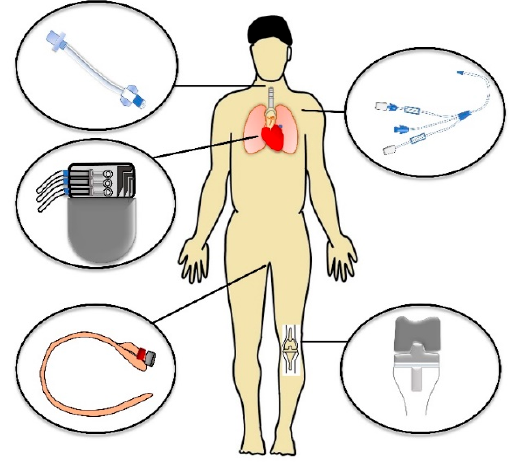
Figure 1. Schematic diagram of the most common locations of medical devices.